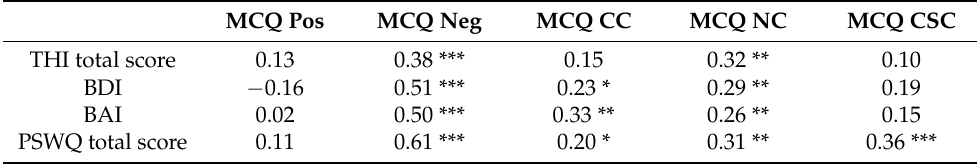
Table 3. Correlations of tinnitus distress and meta-cognitions, anxiety, depression and worries. MCQ Pos